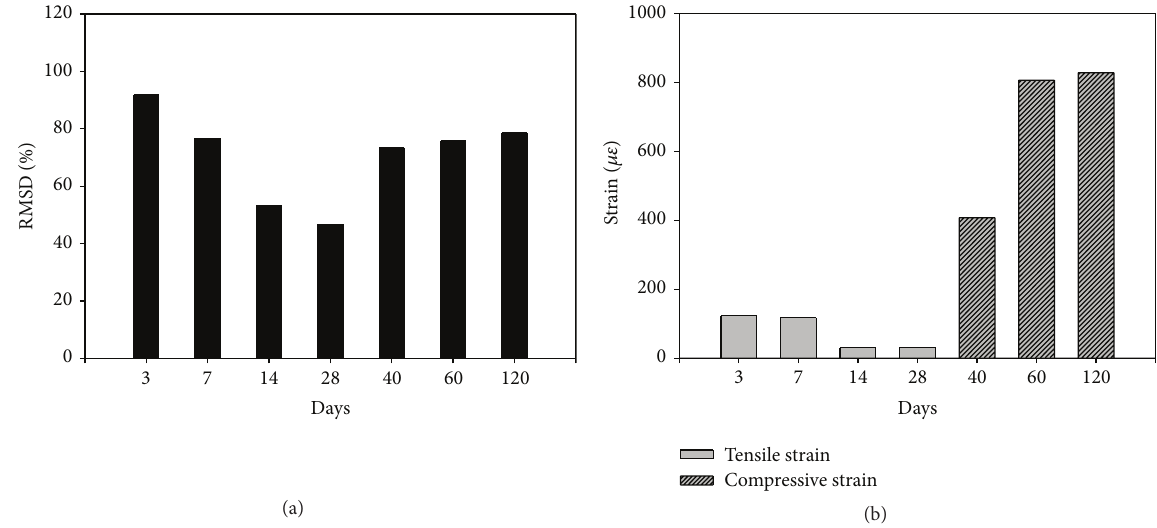
Figure 18: Measurements for PZT1: (a) RMSD value and (b) strain of concrete around EMI sensor.